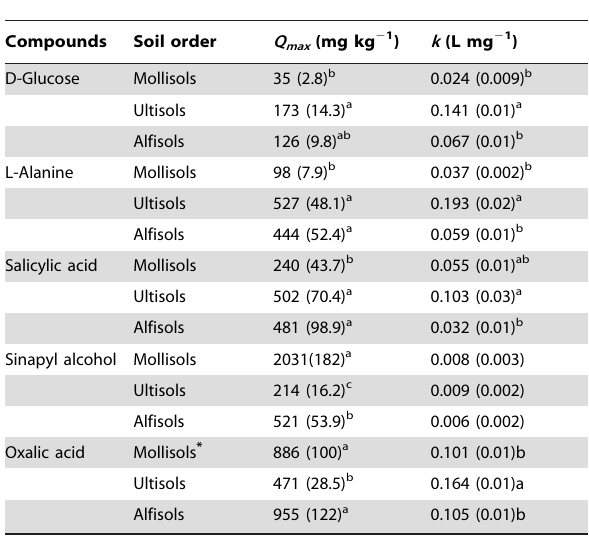
Table 2. Maximum sorption capacity ( Q max ) and binding coefficient ( k ) determined by fitting to the Langmuir